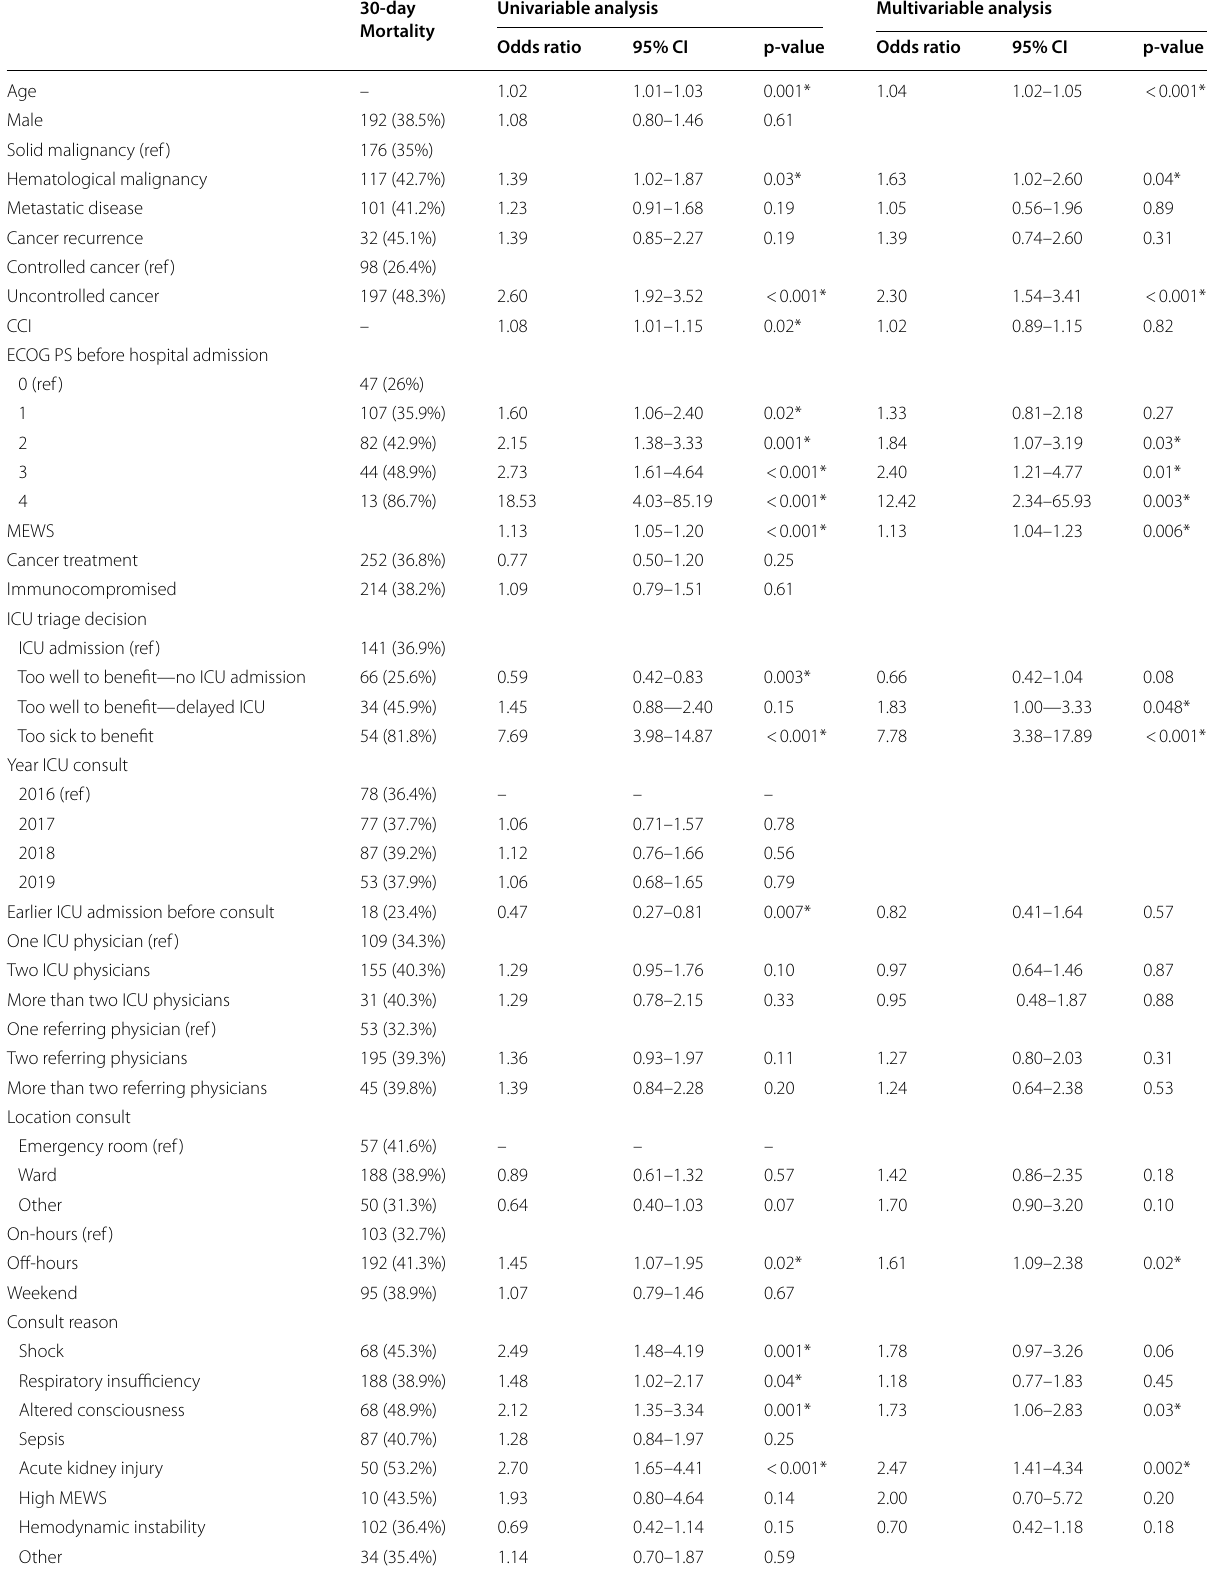
Table 2 Univariable and multivariable analysis: factors associated with 30-day